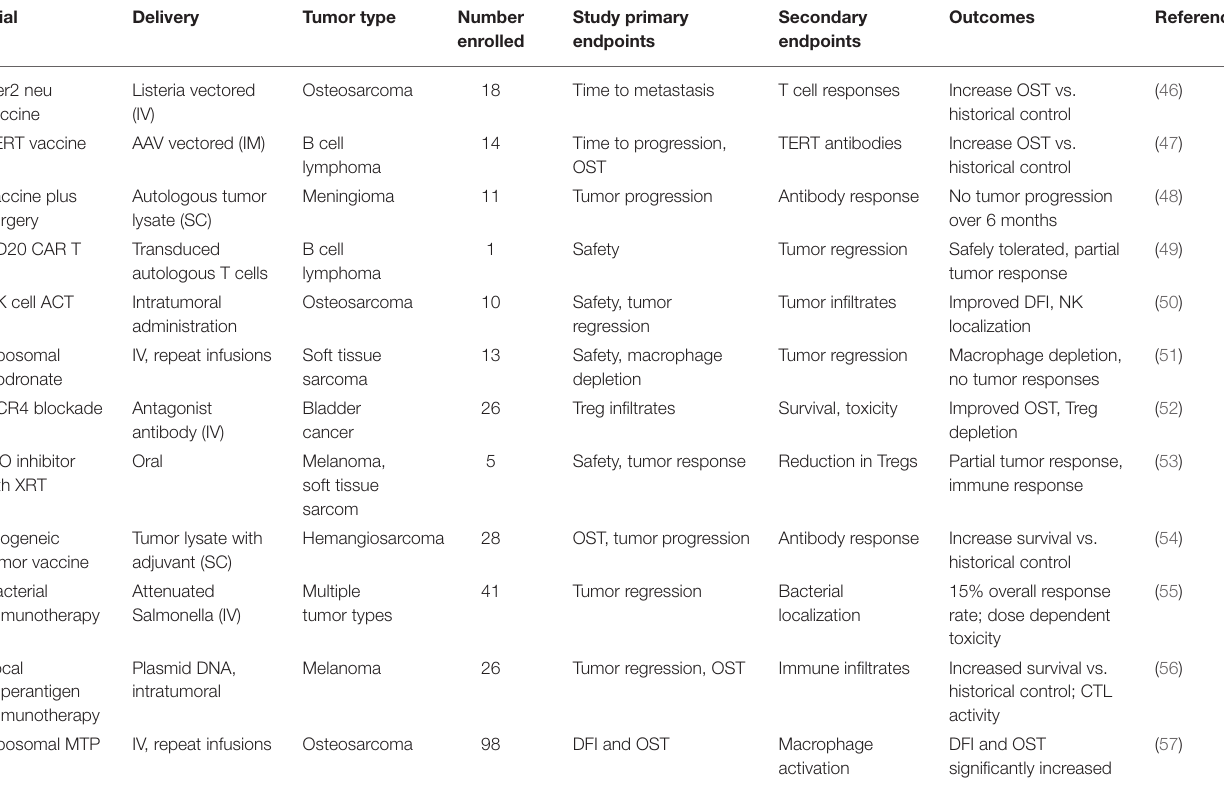
TABLE 1 | Summary of relevant canine cancer immunotherapy trials and